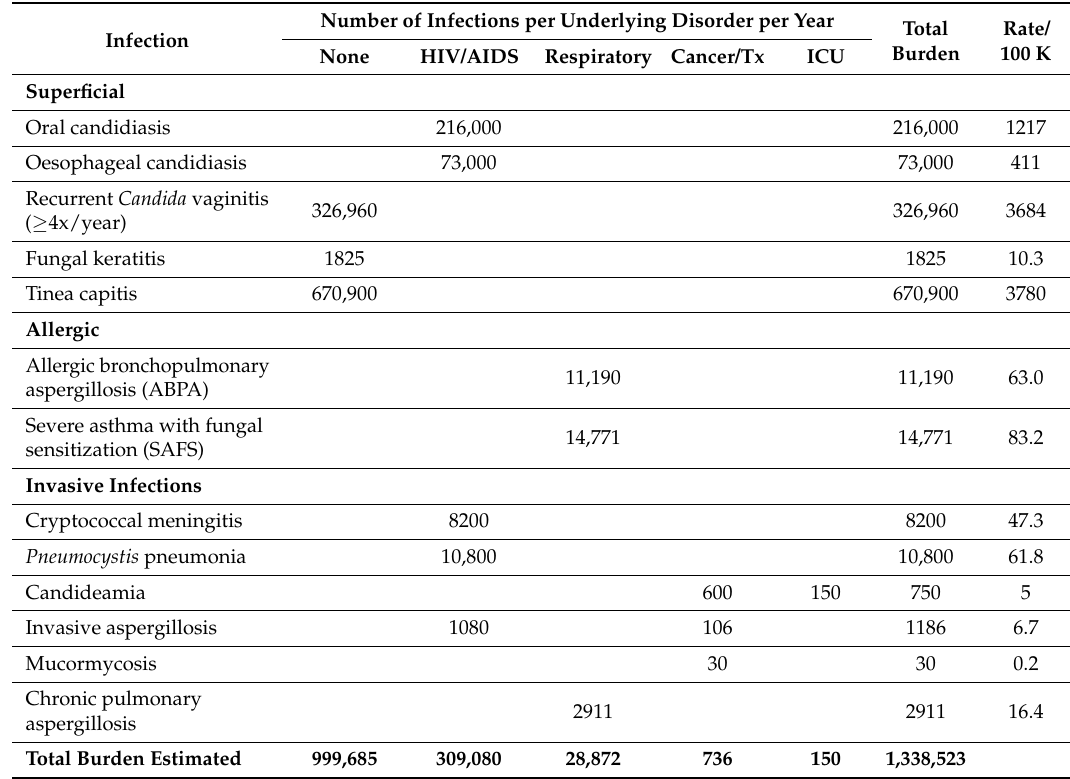
Table 1. The total estimated burden of fungal infections is